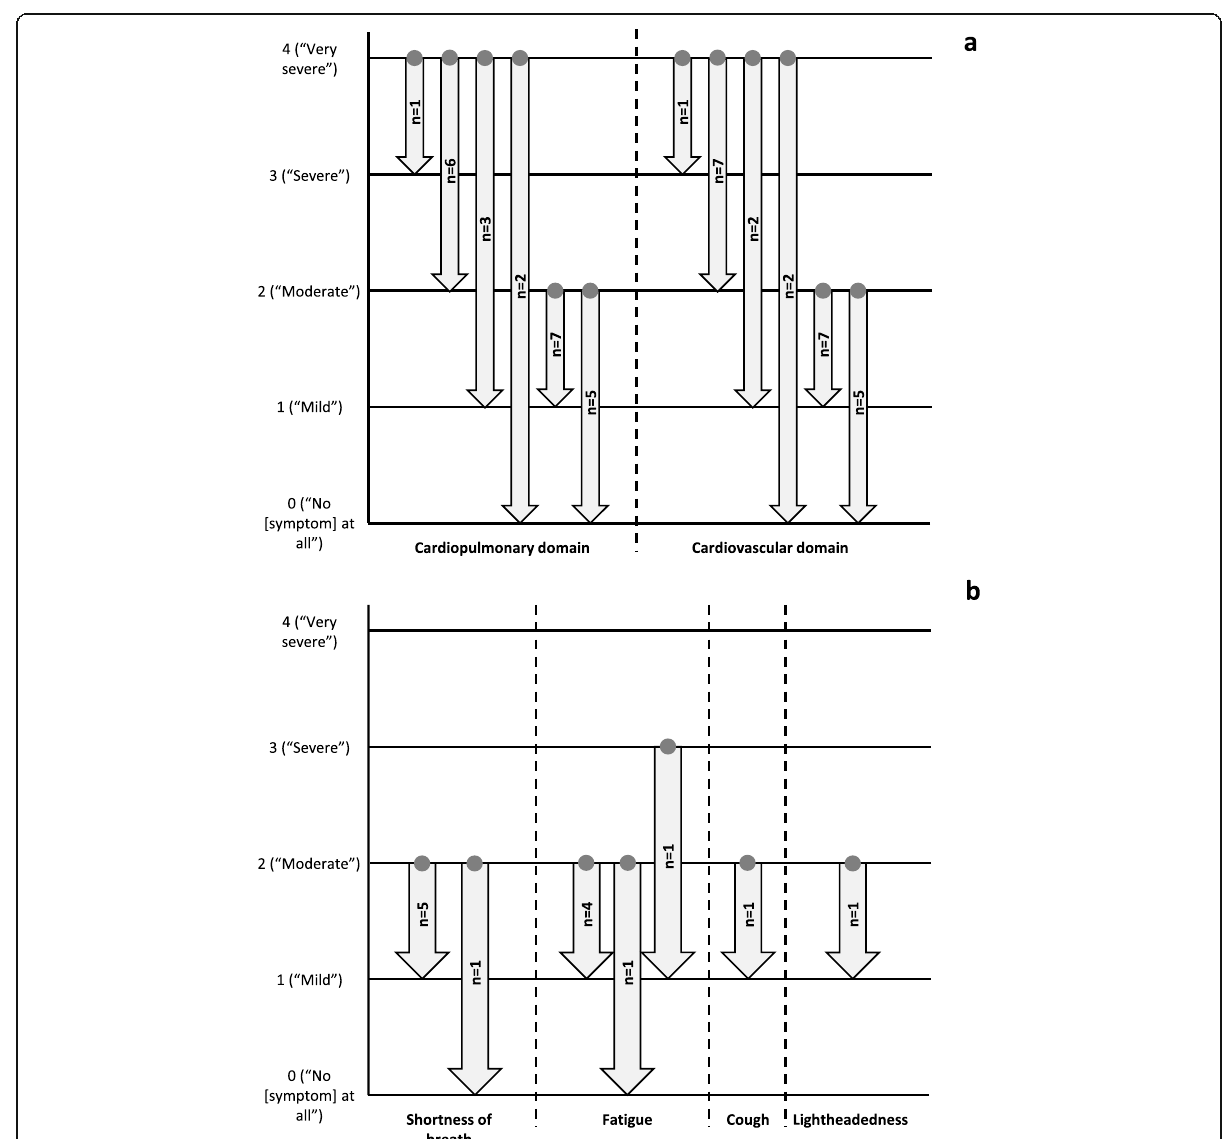
Fig. 1 Meaningful change for symptoms. a Symptom domains. b Individual symptom items. The starting point when discussing meaningful change (denoted by the dots at the base of the arrows) was a hypothetical severity level of 4 ( “ Very severe ” ) or 2 ( “ Moderate ” ) for the symptom domains; for the symptom items, the starting point was the response given when completing the PAH-SYMPACT ™ . For each symptom item, only participants who scored the item as 2 or higher when completing the PAH-SYMPACT ™ were included in the meaningful change discussions. Cardiopulmonary domain: shortness of breath, fatigue, lack of energy, swelling in the ankles or legs, swelling in the stomach area, and cough; cardiovascular domain: heart palpitations, rapid heartbeat, chest pain, chest tightness, and